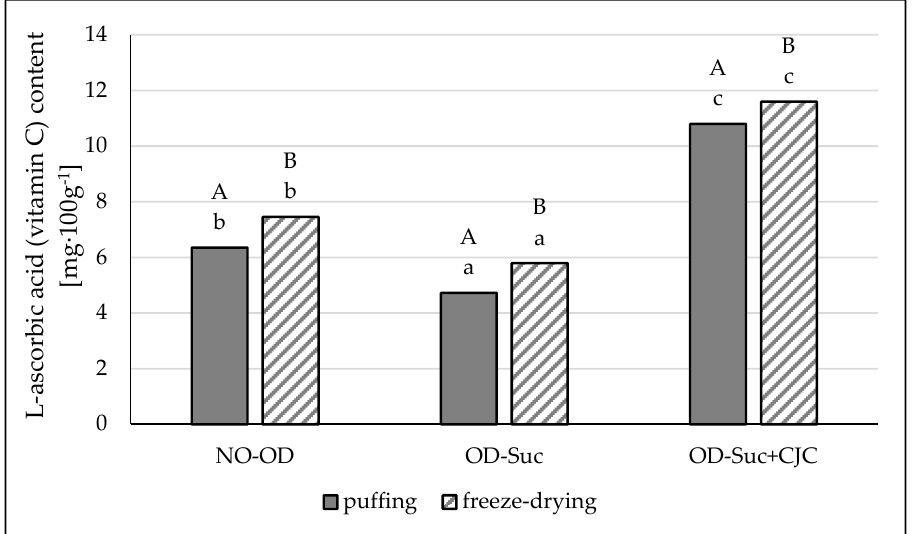
Figure 2. The influence of the type of osmotic solution and drying method on the vitamin C content in apple samples: dried by “puffing” or freeze-drying way; no pre-treated (NO-OD), pre-osmotic dehydrated in sucrose (OD-Suc) or in sucrose with chokeberry juice concentrate solution (OD-Suc + CJC). The same letter, a, b, c indicates a lack of statistically significant differences in the type of osmotic solution and A, B in the drying method.